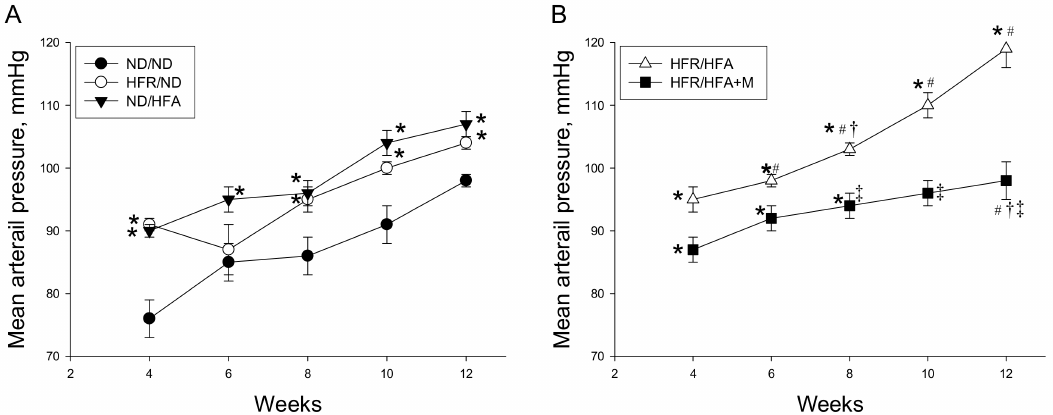
Figure 1. ( A ) Effect of maternal high-fructose (HFR) and post-weaning high-fat (HFA) intake on mean arterial pressure in male offspring; ( B ) Effect of metformin (M) on mean arterial pressure in male offspring exposed to HFR/HFA. * p < 0.05 vs. ND/ND, # p < 0.05 vs. HFR/ND, † p < 0.05 vs. ND/HFA, ‡ p < 0.05 vs.